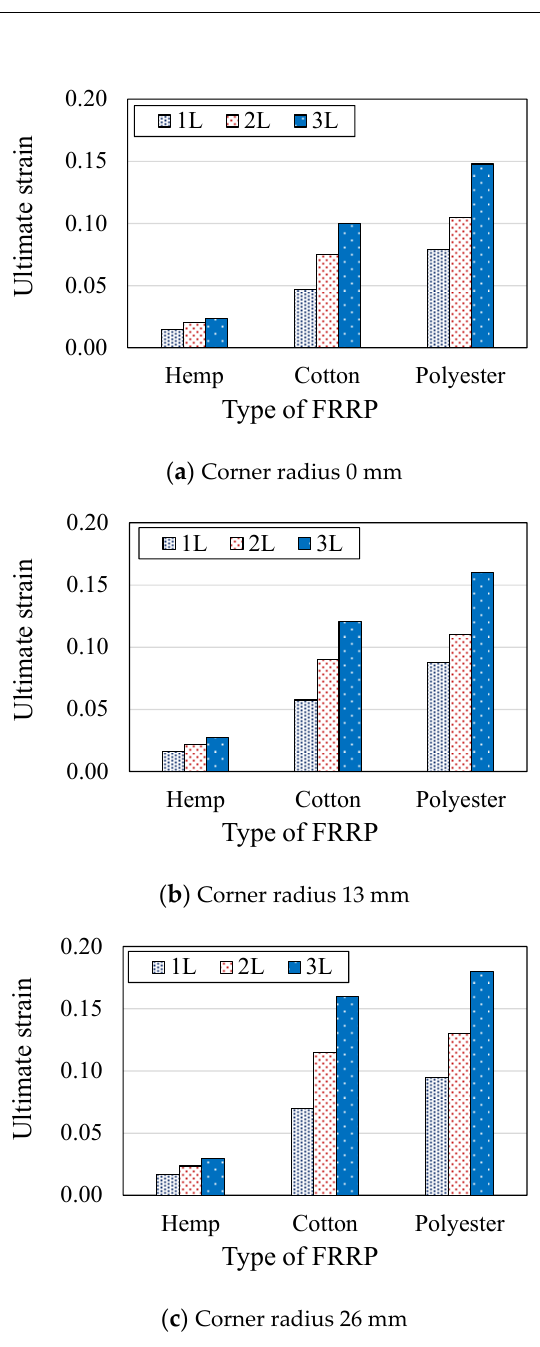
Figure 12. Effects of fiber ropes on ultimate strain (1L = 1 layer of FRRP, 2L = 2 layers of FRRP, 3L = 3 layers of FRRP).